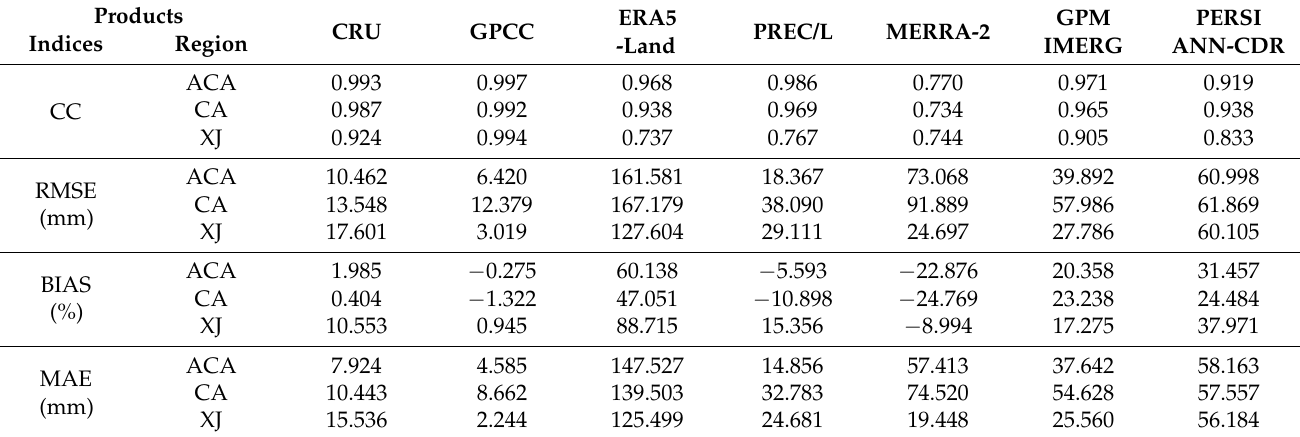
Table 2. Performance of the seven precipitation products based on four indices at an annual